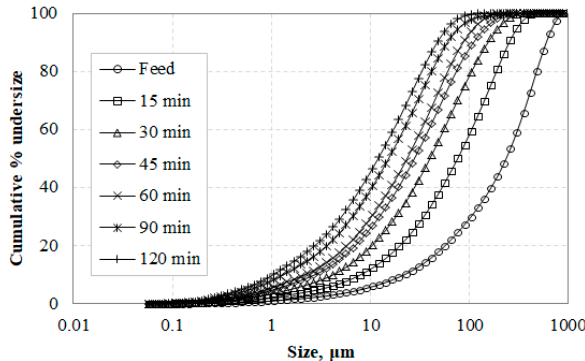
Figure 2. Variation of particle size distribution with grinding time.